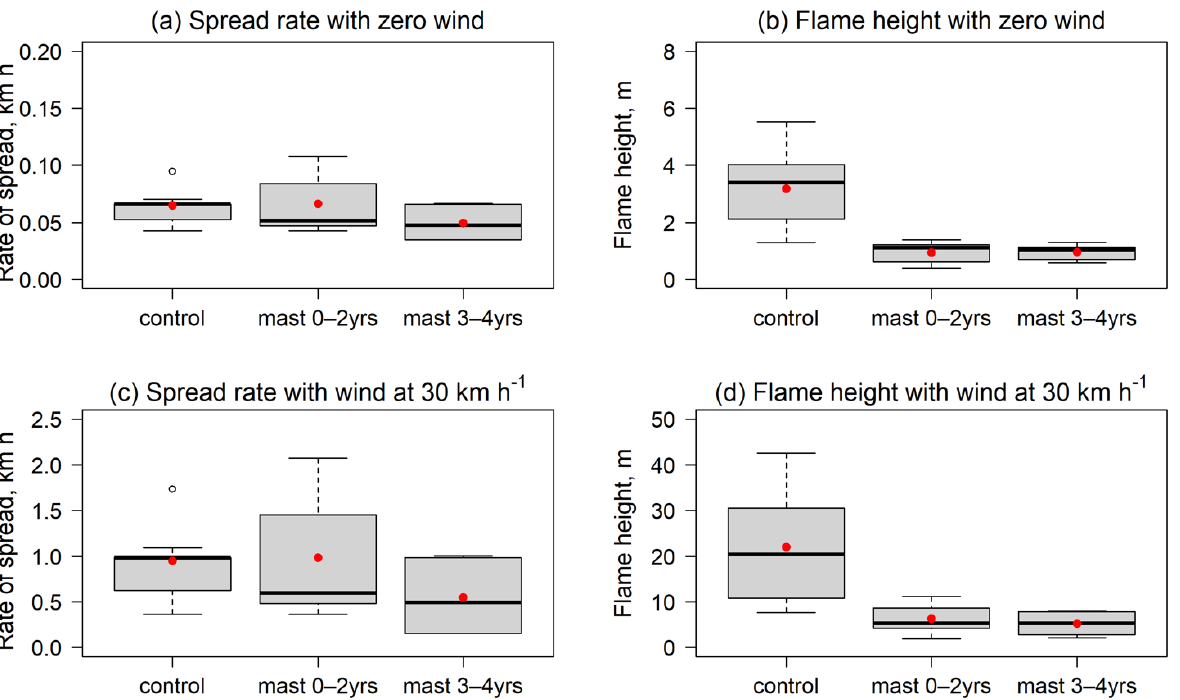
Figure 6. Box plots showing predicted forward rate of spread (km h −1 ) for ( a ) zero wind and ( c ) 30 km h −1 wind speeds and flame height (m) for ( b ) zero wind and ( d ) 30 km h −1 wind speeds for 0–2 years post mastication, 3–4 years post mastication and control. The means are indicated by a red dot.